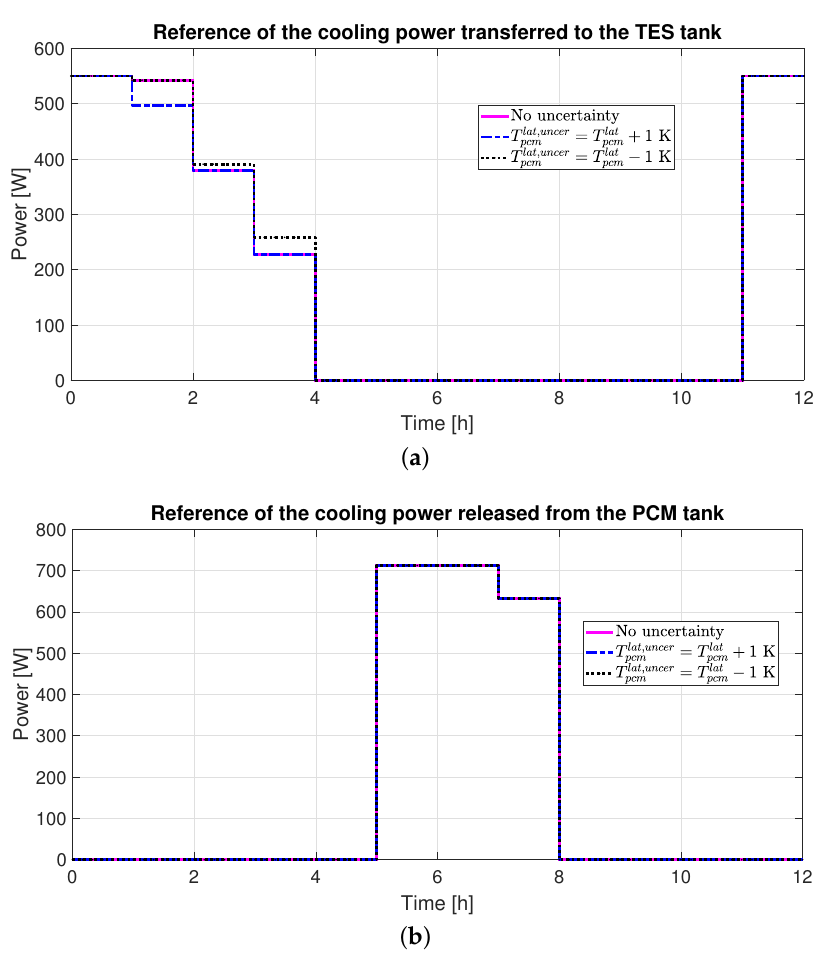
Figure 16. References of the TES charging/discharging cooling powers when some prediction model uncertainty is considered. ( a ) Reference on ˙ Q TES . ( b ) Reference on ˙ Q TES , sec .